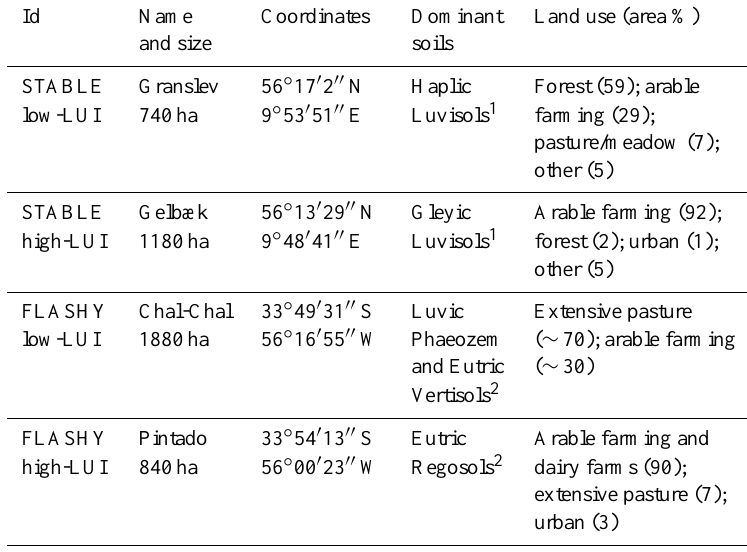
Table 1. Site coordinates (datum WGS84), name and catchment size, dominant soils and land use. Danish catchments are part of Gudenå River basin, and the Uruguayan streams are part of the Santa Lucía Chico River basin. Id Name Coordinates Dominant Land use (area %) and size soils STABLE Granslev 56 ◦ 17 (cid:48) 2 (cid:48)(cid:48) N Haplic Forest (59); arable low-LUI 740ha 9 ◦ 53 (cid:48) 51 (cid:48)(cid:48) E Luvisols 1 farming (29); pasture/meadow (7); other (5) STABLE Gelbæk 56 ◦ 13 (cid:48) 29 (cid:48)(cid:48) N Gleyic Arable farming (92); high-LUI 1180ha 9 ◦ 48 (cid:48) 41 (cid:48)(cid:48) E Luvisols 1 forest (2); urban (1); other (5) FLASHY Chal-Chal 33 ◦ 49 (cid:48) 31 (cid:48)(cid:48) S Luvic Extensive pasture low-LUI 1880ha 56 ◦ 16 (cid:48) 55 (cid:48)(cid:48) W Phaeozem ( ∼ 70); arable farming and Eutric ( ∼ 30) Vertisols 2 FLASHY Pintado 33 ◦ 54 (cid:48) 13 (cid:48)(cid:48) S Eutric Arable farming and high-LUI 840ha 56 ◦ 00 (cid:48) 23 (cid:48)(cid:48) W Regosols 2 dairy farms (90); extensive pasture (7); urban